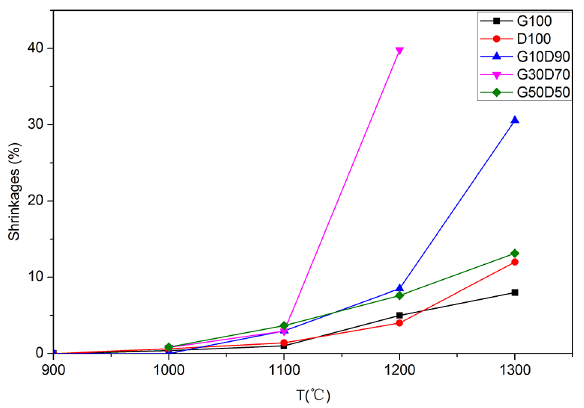
Figure 2. Shrinkages of discs made of G100, D100, G10D90, G30D70, and